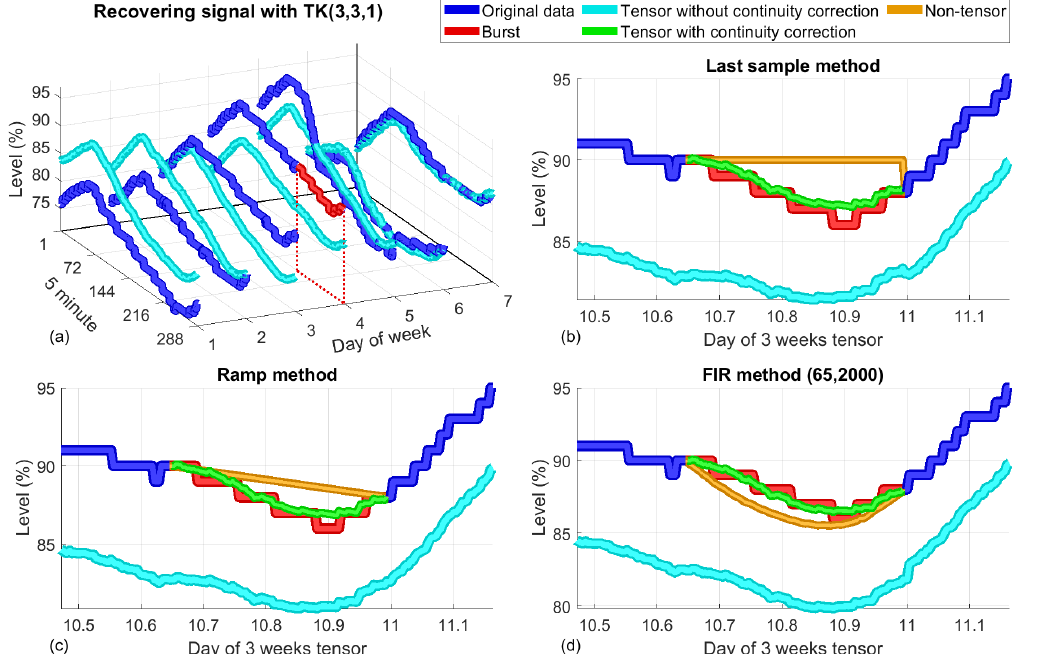
Figure 16. An example of the restoration stages. The tensor contains three weeks worth of data (288,7,3). The burst is 100 samples long, and its position is randomly selected: ( a ) shows the week of the tensor where the burst is located, χ ( :, :,1 ) , corresponding to week 2. Parts ( b – d ) show the three steps of the restoration process for the last sample , the ramp , and the FIR methods,